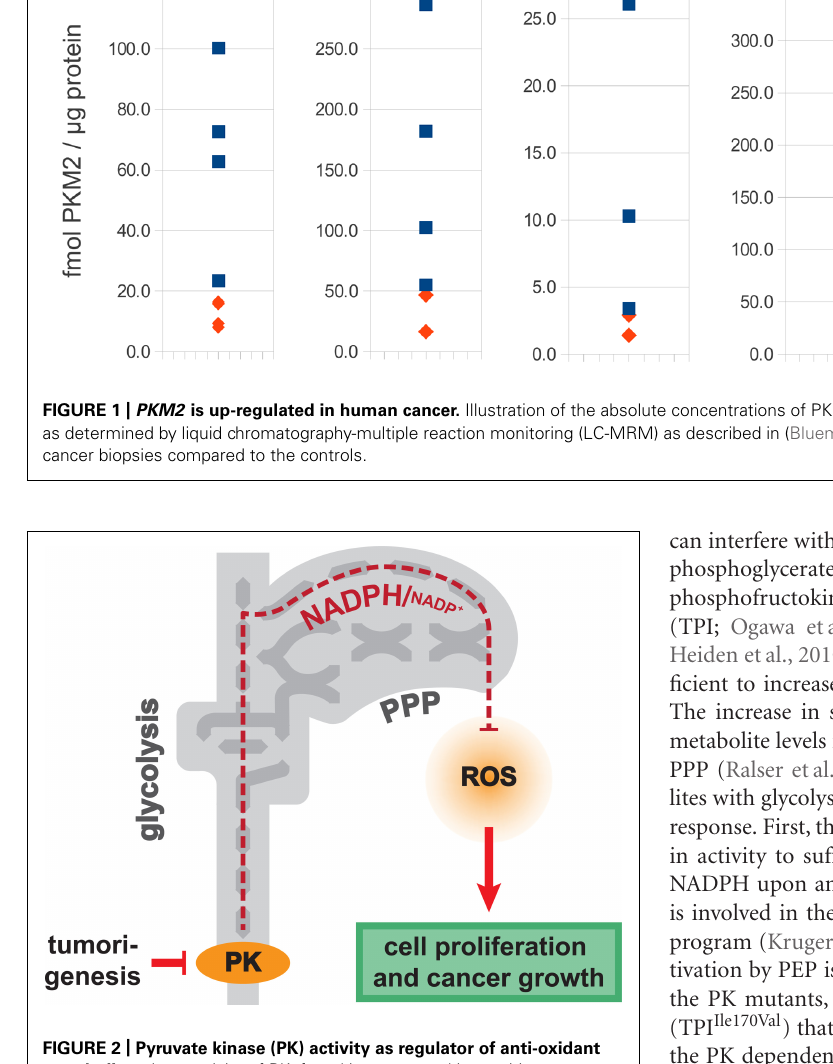
FIGURE 2 | Pyruvate kinase (PK) activity as regulator of anti-oxidant metabolism. Low activity of PK, found in cancer and in respiring yeast, leads to increased flux of the pentose phosphate pathway. Increased PPP activity is required for maintaining the redox balance under conditions with high ROS load: reduced NADPH is required as redox-power for anti-oxidant enzymes, and PPP activity stimulates the anti-oxidative gene expression